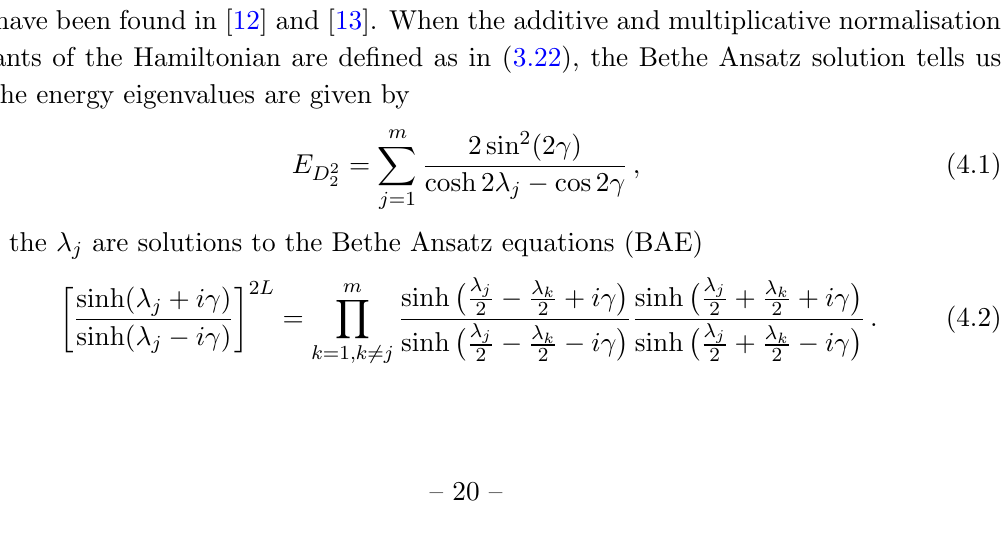
chain with L = 4, in the limit (cid:13) ! 2